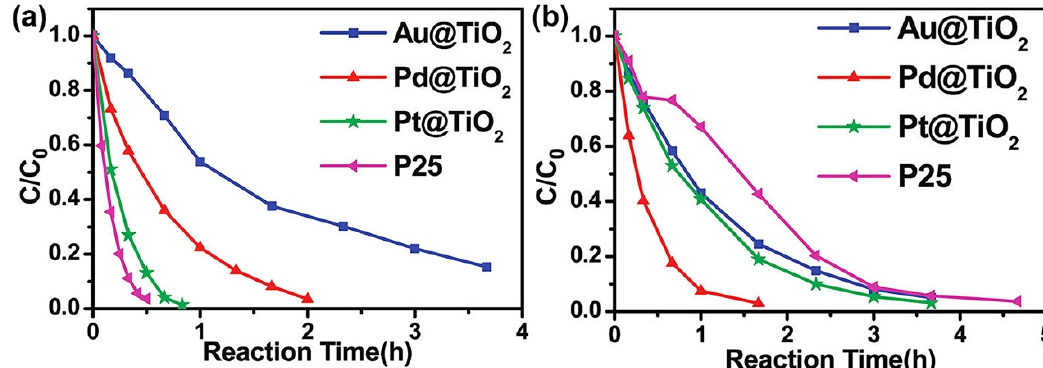
Figure 6. ( a ) Degradation of RhB by P25 and M@TiO 2 (M = Au, Pd and Pt) under UV irradiation; ( b ) Degradation of RhB by P25 and M@TiO 2 (M = Au, Pd and Pt) under visible light irradiation. Reproduced from [90], with copyright permission from American Chemical Society, 2011.